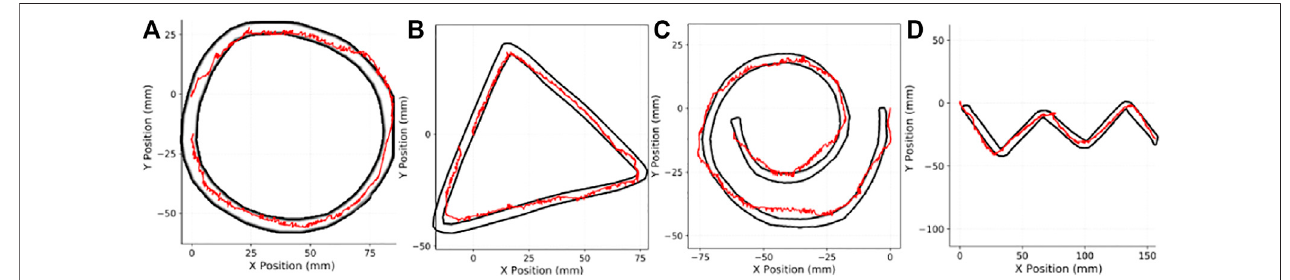
FIGURE 13 | Edge tracking shapes, and results. (A) Circular edge, (B) Triangular edge, (C) spiral edge, (D) Zig-Zag Edge.